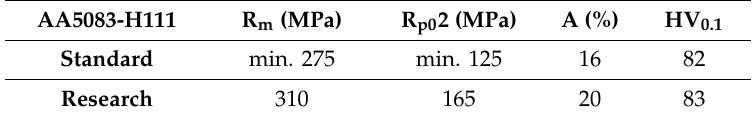
Table 2. Mechanical properties of AA5083-H111 according to the standard and own research.